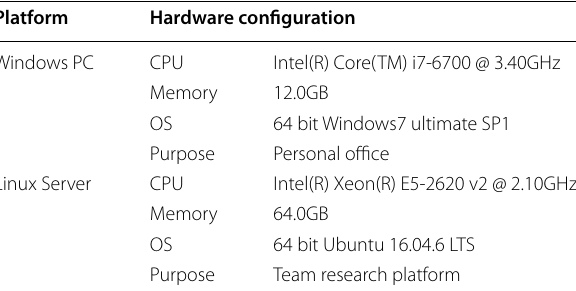
Table 7 Hardware configuration of monitored